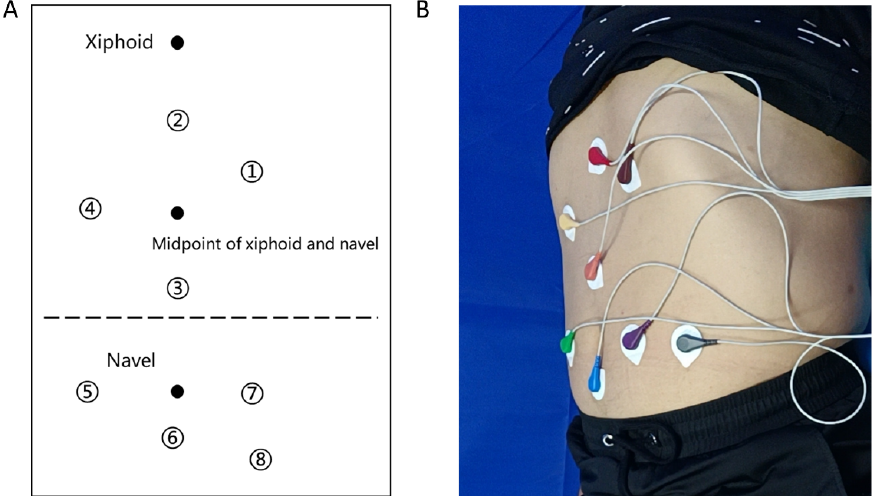
Figure 1. ( A ) A pattern diagram of electrode positioning for EGEG recording. The eight electrodes represent eight channels used to reflect the myoelectrical activity of the corpus gastricum, lesser curvature, greater curvature, antrum, ascending colon, transverse colon, descending colon, and rec ‐ tum. ( B ) A diagram of the process in EGEG examination. EGEG,